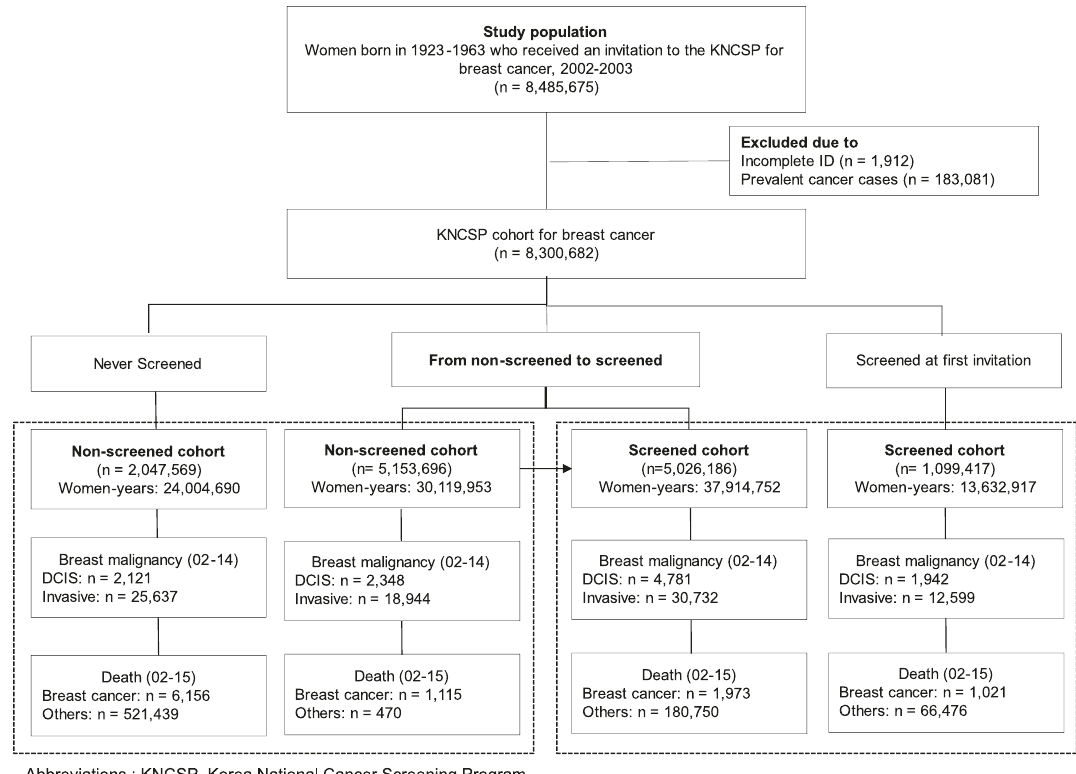
Fig. 1 Flow diagram for the study-cohort in the Korean National Cancer Screening Program. Exposure to breast cancer screening was de fi ned using a modi fi ed never/ever approach by which women were considered ever screened after their fi rst screening attendance (see "Methods"). Table 2. Crude incidence rates and adjusted incidence rate ratios for breast cancer and crude mortality rates and adjusted mortality rate ratios for breast cancer and all causes of mortality except from breast cancer between the screened and non-screened women in the KNCSP. No. of